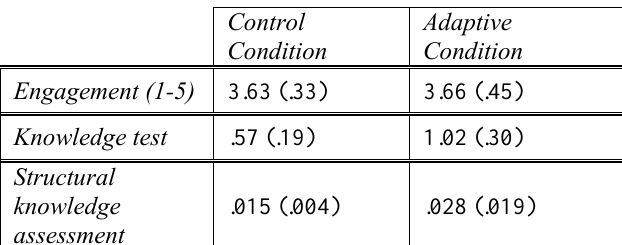
Table 1: Mean engagement and efficiency scores on knowledge test and structural knowledge assessment